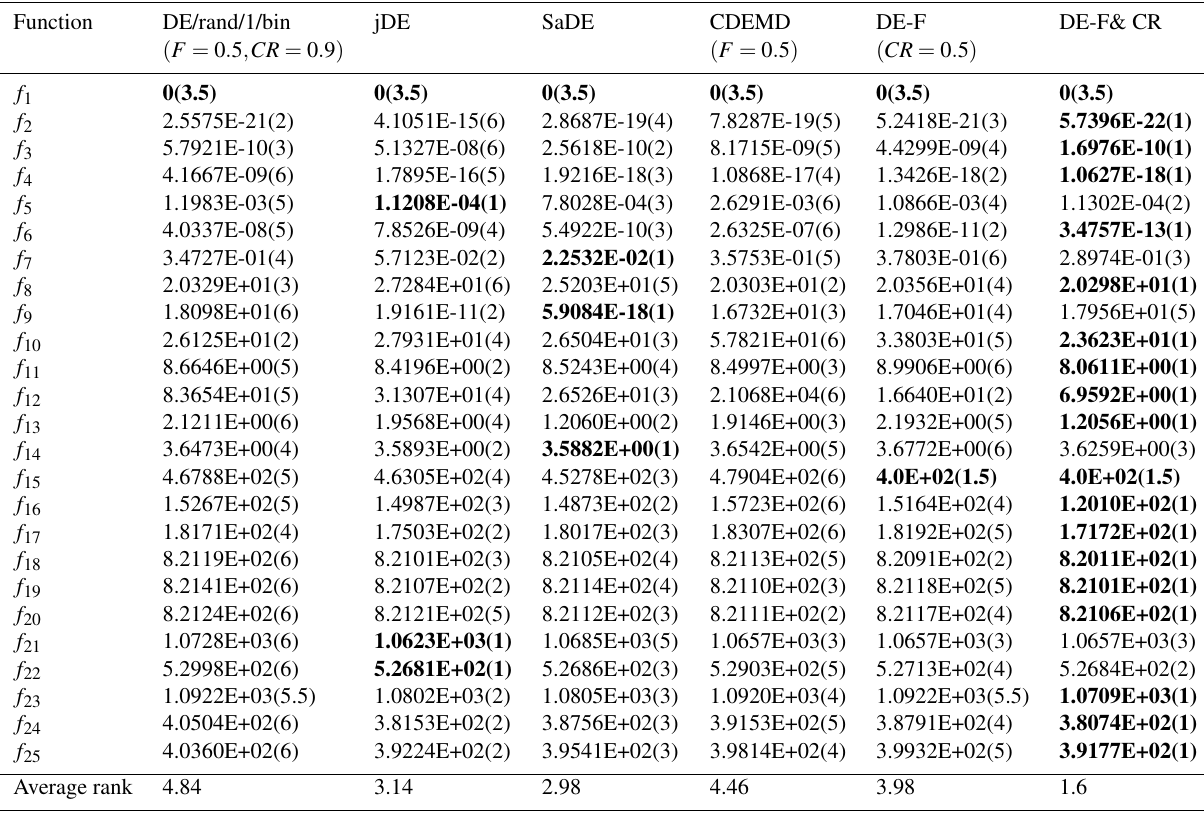
Table 3. Mean and ranks of the best error values for D